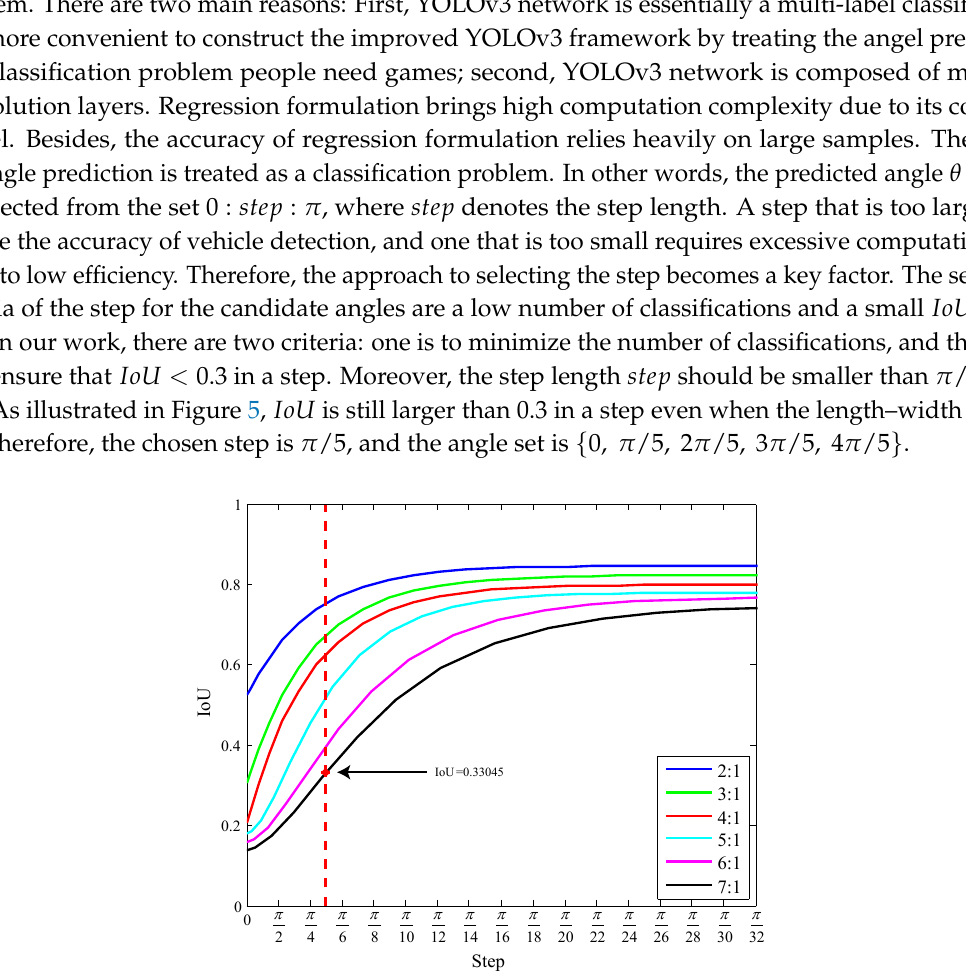
Figure 5. Relations between the step and IoU with different length–weight